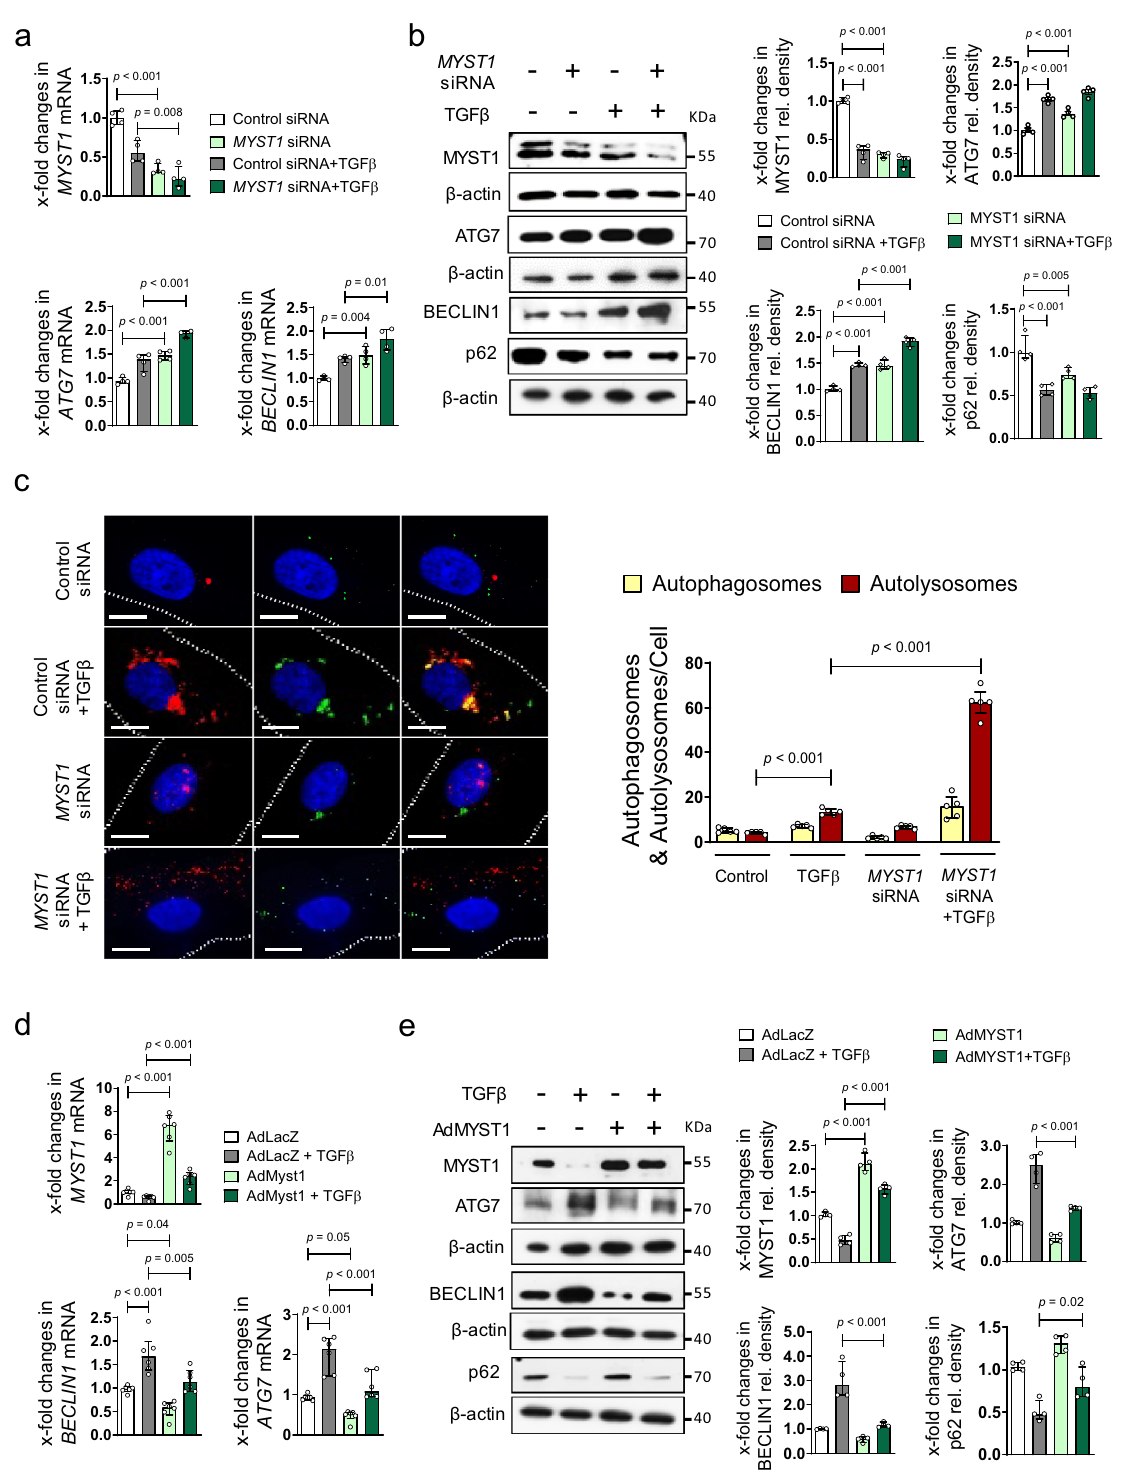
Fig. 4 Downregulation of MYST1 mediates the stimulatory effects of TGF β on autophagy. a , b Effects of siRNA-mediated knockdown of MYST1 on autophagy in healthy human dermal fi broblasts as assessed by quanti fi cation of the mRNA levels of ATG7 ( n = 4 biological replicates per group and n = 3 for MYST1 siRNA + TGF β ), BECLIN1 ( n = 4 biological replicates per group) and respective protein quanti fi cations ( n = 4 biological replicates per group). Con fi rmation of reduced mRNA ( n = 4 biological replicates per group) ( a ) and protein ( b ; n = 4 biological replicates per group) levels of MYST1 by qRT-PCR and western blot. c EGFP/ RFP-LC3 reporter activity upon knockdown of MYST1; representative images and quanti fi cation ( n = 5 biological replicates per group). Horizontal scale bar, 5 µ m. d , e mRNA expression of ATG7 , BECLIN1 , and MYST1 ( n = 6 biological replicates per group) ( d ) and respective protein quanti fi cation ( e ) ( n = 4 biological replicates per group) levels after adenoviral overexpression of MYST1 in healthy human dermal fi broblasts ( e ). All data are presented as mean±IQR. p -values were determined by ANOVA one-way with Tukey ’ s multiple comparison post hoc test. See source data for more detailed information. rel.: relative, Ad: adenovirus. The results in panel c are part of a large set of experiments and share controls with Supplementary Fig. 8a. Data are presented separately just for the purpose of this fi